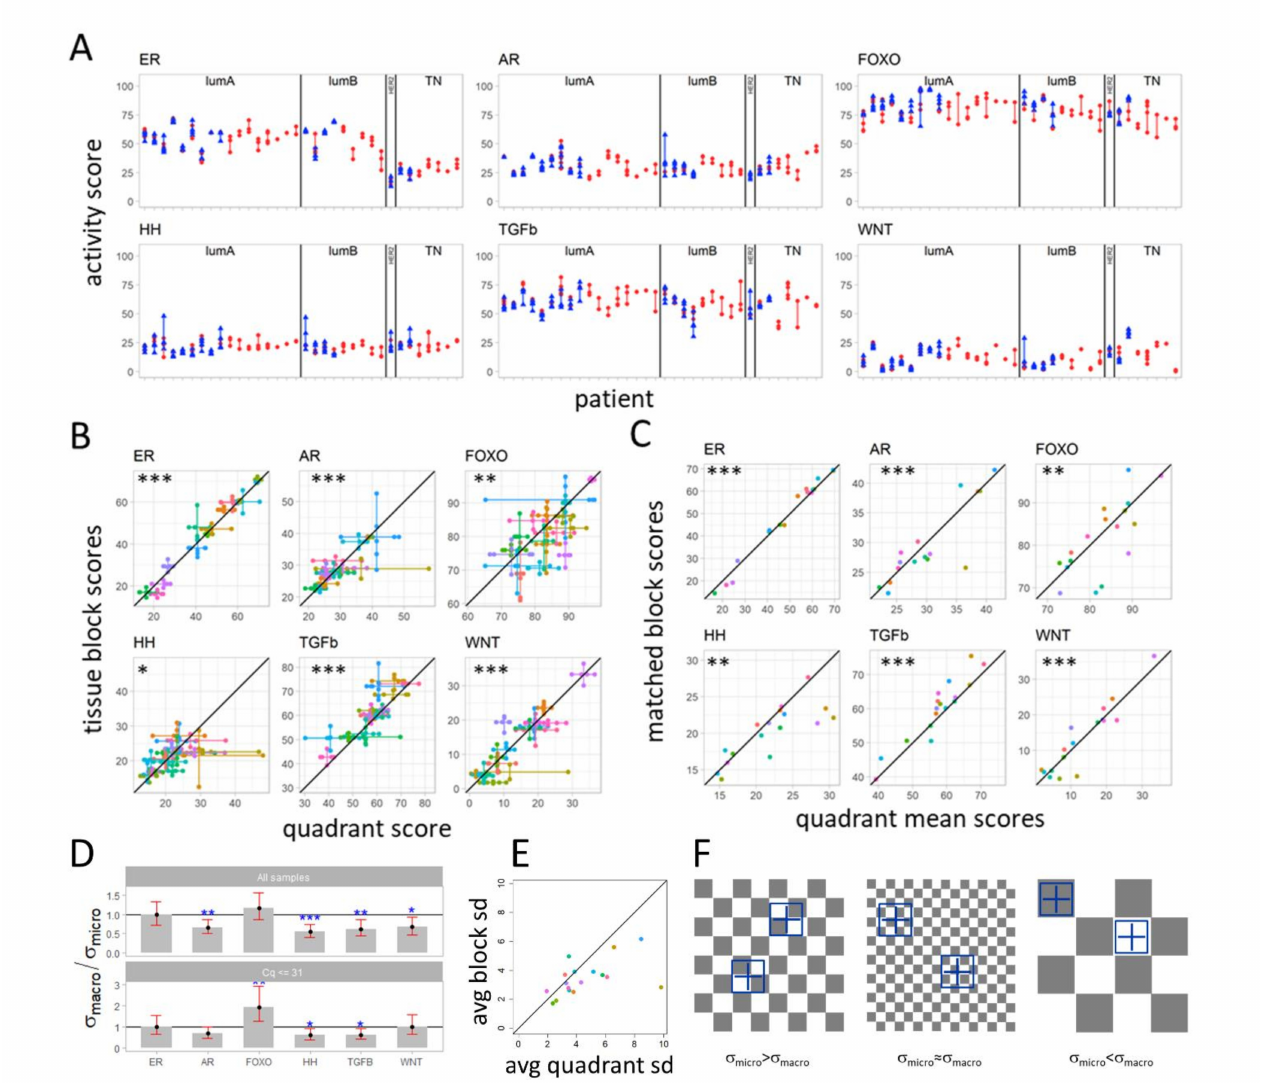
Figure 4. Heterogeneity in signaling pathway activity score within primary tumors at micro- and macro-scale (sample sets I and II). ( A ) Pathway activity scores for tissue block (blue) and quadrant (red) samples of each patient. Ranges are presented as vertical lines; individual scores are presented as triangles. ( B ) Spread in signaling pathway activity scores from quadrant samples (horizontal lines) vs. spread in scores from tissue block samples of the same patient (vertical lines). Significance level for the correlation between mean scores of tissue block samples versus mean scores of quadrant samples (point where horizontal and vertical lines cross) are indicated in the figure by stars (*: p < 0.05, **: p < 0.01, ***: p < 0.001, corresponding values are in Table S8). ( C ) Correlation between mean quadrant sample pathway activity score and score of the corresponding tissue block sample. Stars indicate the significance level of the correlations (corresponding p values are in Table S8). ( B , C ) Diagonal black lines illustrate a one-to-one relation. Samples of the same patient have the same color. Black lines illustrate a one-to-one relation. ( D ) Ratio between macro-scale and micro-scale standard deviation (SD) of signaling pathway activity scores; σ macro / σ micro measured in tissue block samples and quadrant samples, respectively. Variances computed using the macro- vs. micro-scale model (Figure 2B, Supplementary Materials Statistics, Figure S2, Table S6) using all samples (top) or those with less technical noise (leaving out all samples with average Cq values > 31 for the reference genes used for the qPCR measurements). Significance level of Wald test p -value for comparing the ratio σ macro / σ micro to 1 are indicated by stars ( p values for model run using all samples in Supplementary Materials Statistics, Table S7). ( E ) Summarized macro (block level) and micro-scale (quadrant level) heterogeneity per patient by taking the square root of the average variance across the six pathways, where an average SD of 10 means an average confidence interval of about 40 points. ( F ) Checkerboard visualization of a primary cancer, explaining differences in heterogeneity between micro-scale and macro-scale measurements of pathway activity. Left: Squares represent (small) cancer cell